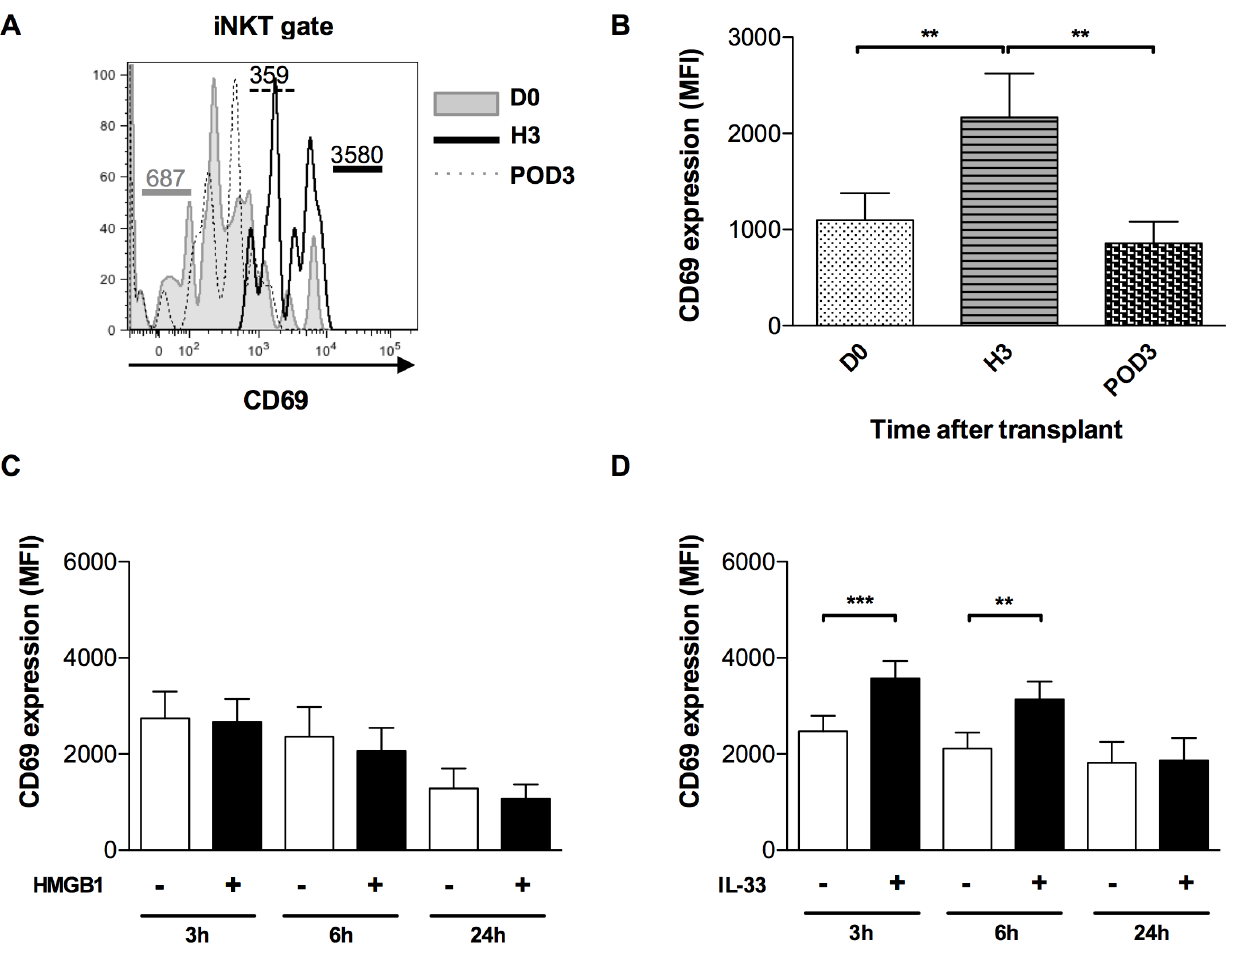
Figure 4. Early activation of iNKT cells after renal IRI: a potential role for IL-33. (A, B) PBMCs from kidney graft recipients were recovered before transplantation (D0), and 3 hours (H3) and day 3 (POD3) after transplantation. They were membrane-labelled with anti-CD3-FITC, anti-iNKT-PE 6B11 clonotype, and anti-CD69-PerCP/Cy5.5. CD69 analysis was performed by flow cytometry gating on CD3( + )6B11( + ) cells, defined as iNKT cells: (A) Flow cytometry plot showing expression profiles of surface marker CD69 on iNKT cells ex vivo from one representative patient at D0 (filled histogram), H3 (bold line) and POD3 (dotted line). Numbers indicate MFI of CD69 expression on iNKT lymphocytes. (B) Mean Fluorescence Intensity (MFI) of CD69 expression on iNKT lymphocytes from the patient cohort (n=16 at D0, H3, and POD3). (C, D) PBMCs from healthy adult donors (n=6) were cultured with (black columns) or without (white columns) HMGB1(C) or IL-33 (D) for 3, 6 or 24 hours of culture. MFI of CD69 expression on iNKT lymphocytes was analysed by Flow cytometry as described in (A, B). Data are expressed as means 6 SEM. **p , 0.01, ***p , 0.001 by Wilcoxon test.